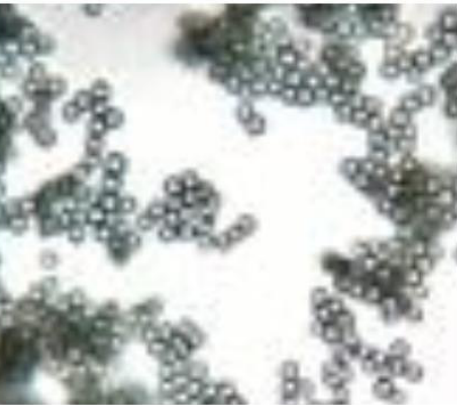
Figure 3. Penicillium Spores collected by electrospray in our laboratory in open air and visualized by Amscope microscopy (×1000).